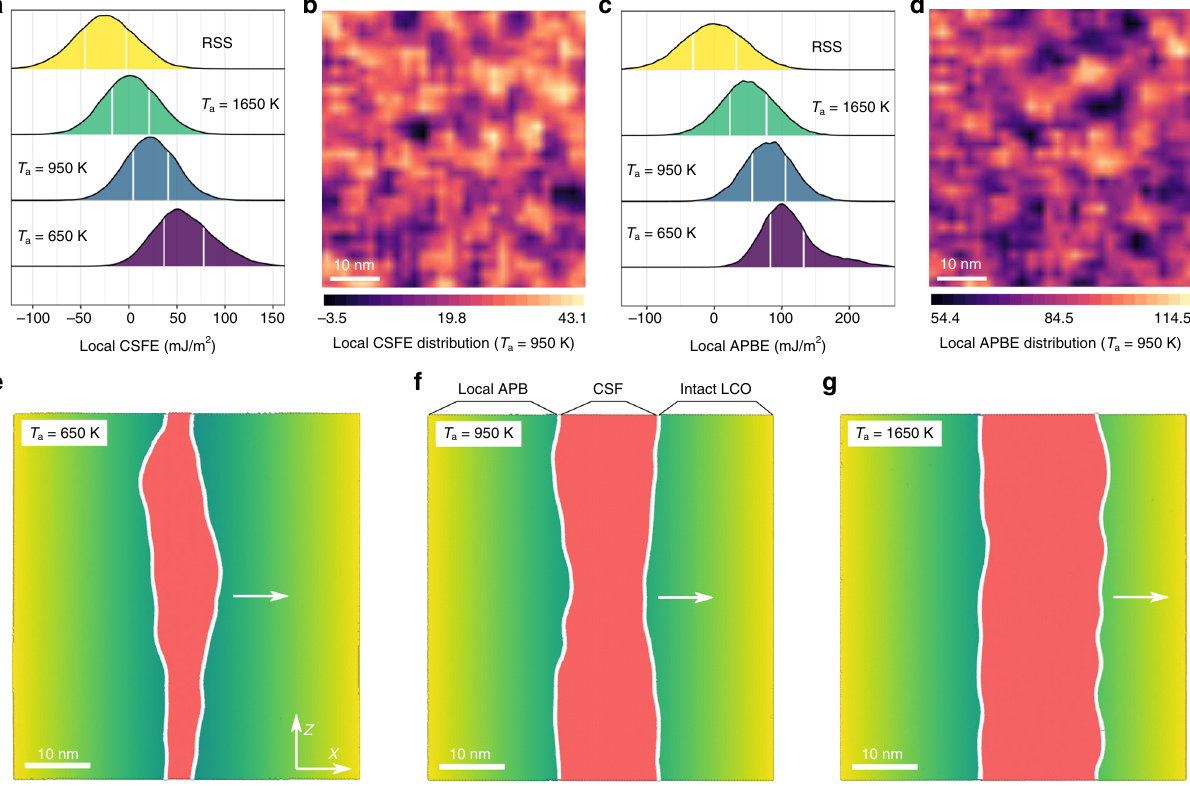
Fig. 3 Statistical distributions of local properties and their effects on dislocation structure. a Probability density distributions of local complex stacking fault energies for samples with T a = 650, 950, and 1650 K, respectively, and random solid solution. The 25 – 75% accumulative probability range is highlighted by white boundaries. b Spatial distribution of local complex stacking fault energies in a sample with T a = 950 K. c Probability density distributions of local antiphase boundary energies for samples with T a = 650, 950, and 1650 K, respectively, and random solid solution. d Spatial distribution of local antiphase boundary energies in a sample with T a = 950 K. e – g Examples of extended screw dislocation in samples with T a = 650, 950, and 1650K, respectively. All con fi gurations in e – g are obtained after a 100 ps relaxation at T = 300 K and under a constant shear stress of 300 MPa. The x - and z- direction are along ½ 11 (cid:1) 2 (cid:3) and ½ 1 (cid:1) 10 (cid:3) , respectively. Periodic boundary conditions are only applied in z- direction. Dislocation cores are represented by the white tubes and complex stacking faults (CSFs) are colored in red. Leading partial dislocation is on the right and trailing partial dislocation is on the